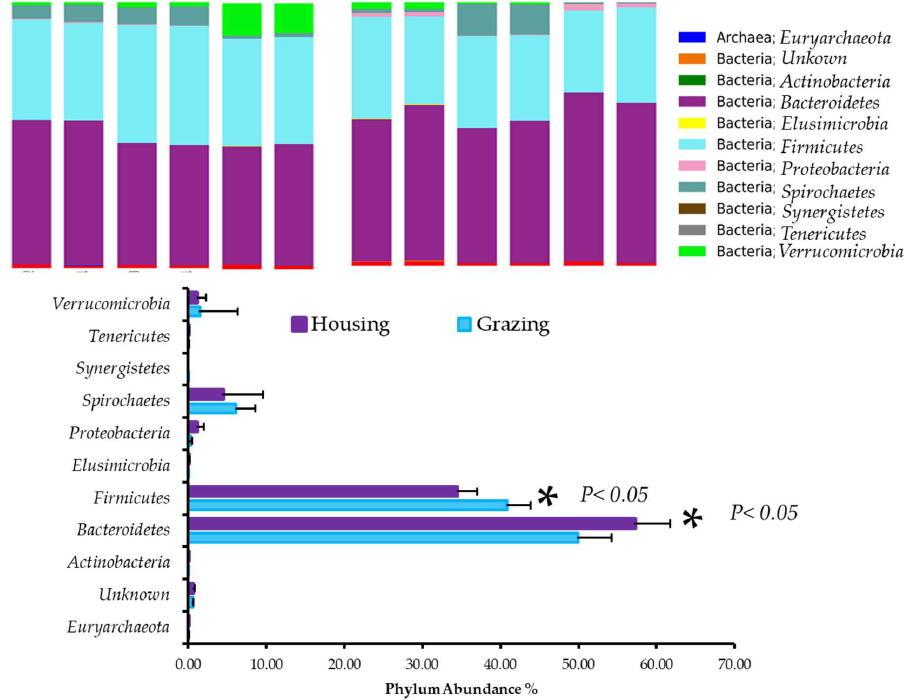
Figure 2. Relative abundance of microbiota changes in grazing and housing steers at the phylum level. Table 2. Microbiota changes at the family level between grazing and housing